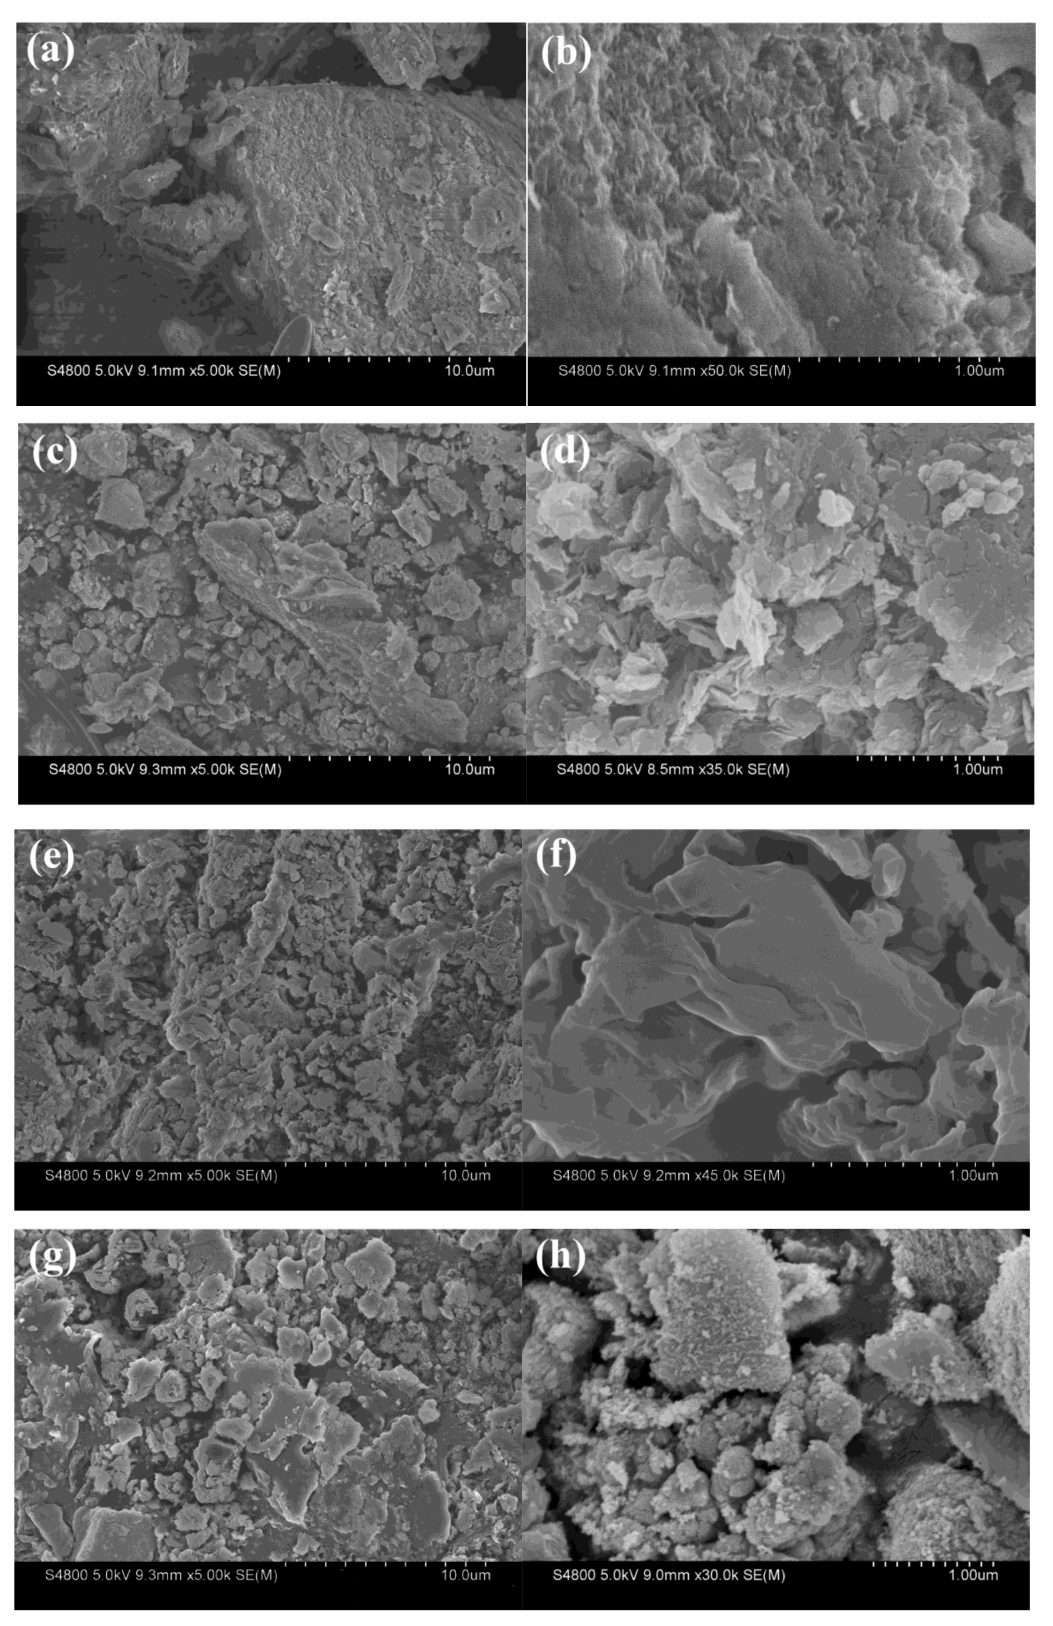
Figure 2. Scanning electron microscopy (SEM) images:( a , b ) are hectorite; ( c , d ) are TiO 2 / hectorite; ( e , f ) are g-C 3 N 4 ; ( g , h ) are g-C 3 N 4 / TiO 2 /